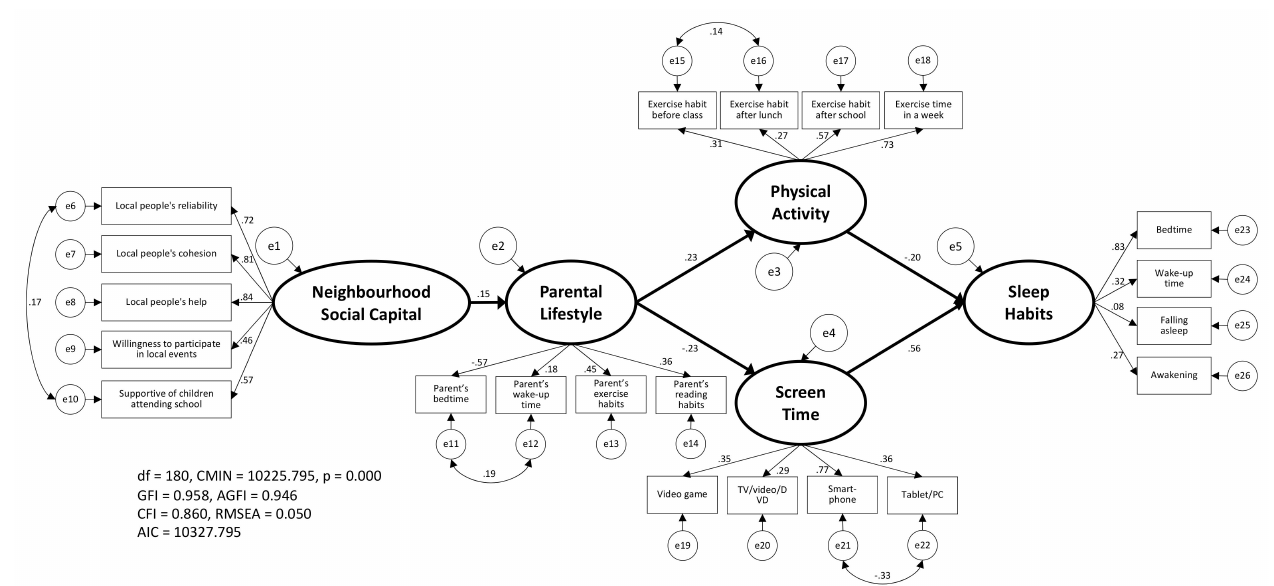
Figure 3. The pathways linking to children’s sleep habits by all samples. This model was verified by structural equation modeling using the bootstrap method. All estimated values in this figure are significant.